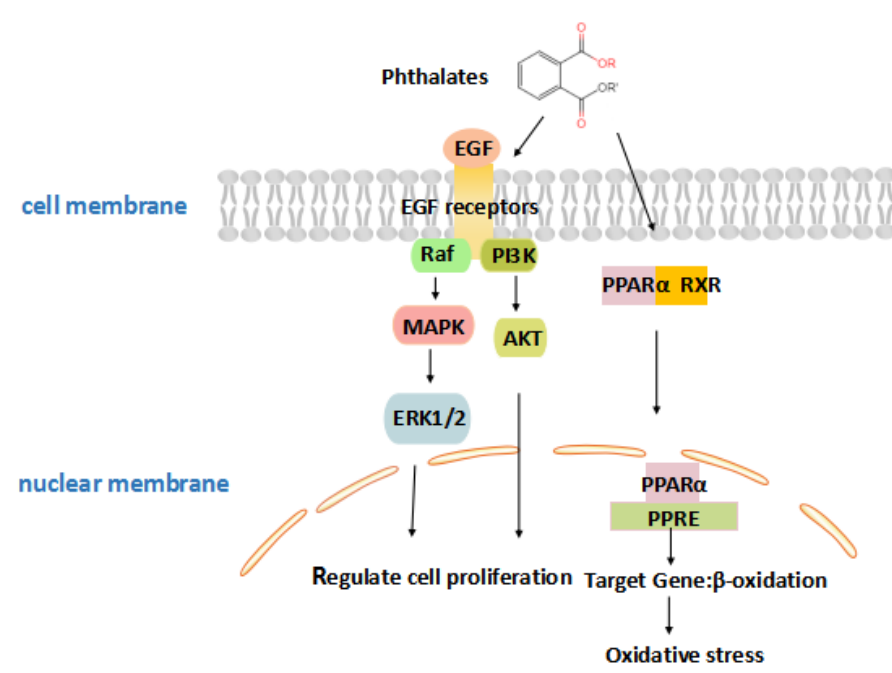
Figure 3. A schematic illustrating the e ff ects of phthalates on placental growth. Phthalates activate peroxisome proliferator-activated receptor (PPAR), which is associated with placental development, or modulate the combination of epidermal growth factor (EGF) and epidermal growth factor receptor (EGFR), and activate phosphatidylinositol 3-kinase / protein kinase B (PI3K / Akt) and signal-regulated kinase (ERK) signaling pathways, then regulate proliferation, survival, and di ff erentiation in the body.